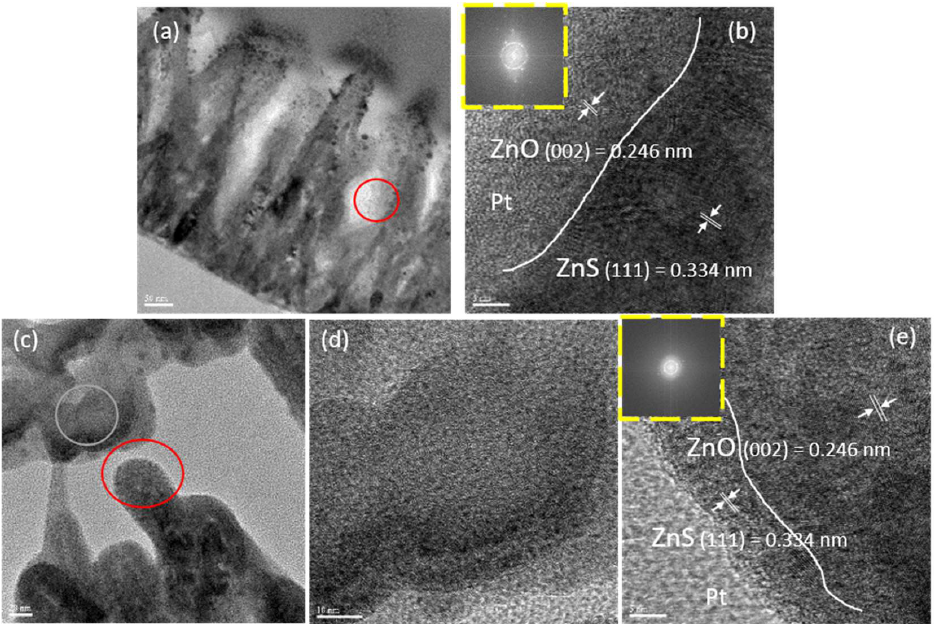
Figure 5. ( a ) A ZnO/ZnS core–shell image, scale bar = 50 nm; ( b ) a HRTEM image of ZnO/ZnS border, scale bar = 5 nm, and a digital microscope-processed image of the ZnO/ZnS interface; ( c ) a TEM image with CNTs (gray circle) and without CNTs (red circle), scale bar = 20 nm; ( d ) a HRTEM image on the grey circle, scale bar = 10 nm; ( e ) a HRTEM image on the red circle, scale bar = 5 nm, and a digital microscope-processed image of the ZnO/ZnS interface.